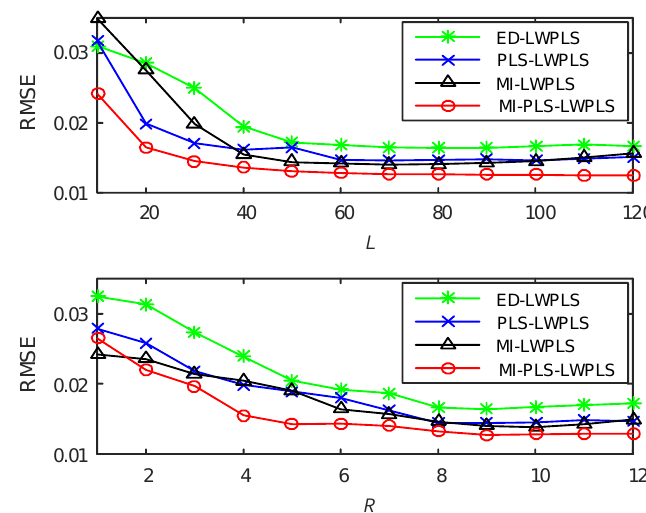
Figure 6. Changes of RMSEs with L and R in the validation set in the four methods.